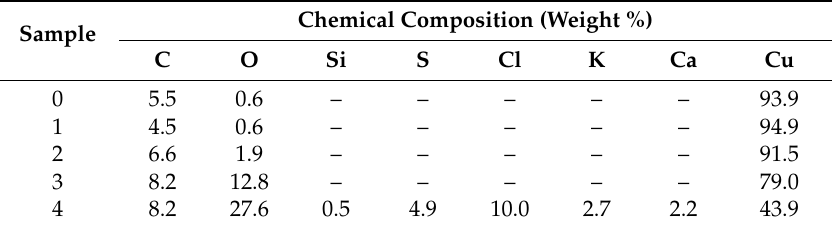
Table 4. EDS chemical composition of the as-received copper samples.